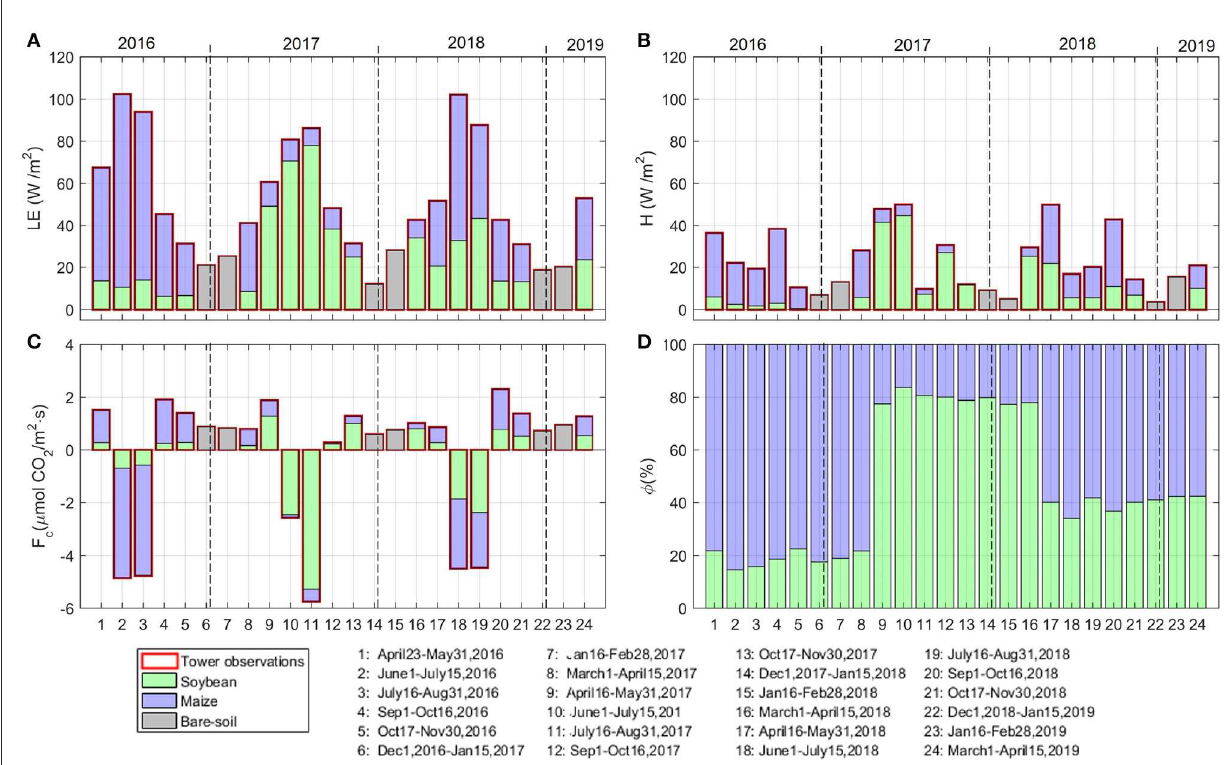
FIGURE7 Seasonal evolution of average daily fluxes due to the relative contribution of maize (blue) and soybean (green) in 6-week windows, for (A) latent heat flux, LE ; (B) sensible heat flux, H ; (C) carbon dioxide flux, F c ; and (D) relative flux footprint contribution, φ . Each stacked bar refers to a 6-week average daily flux for each crop type. Dash vertical lines show the years of analysis. The relative contributions due to soybean and maize were calculated with the method described in Section 3 using 15-minute data, from April 2016 to April 2019.